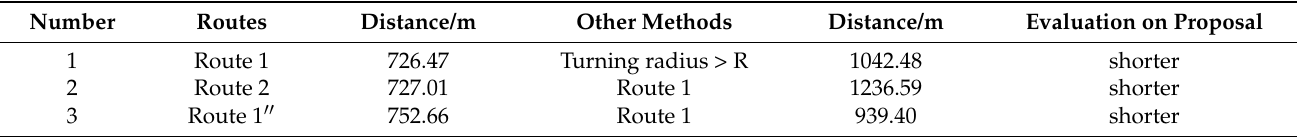
Table 4. Comparison between the proposed methods and other practical